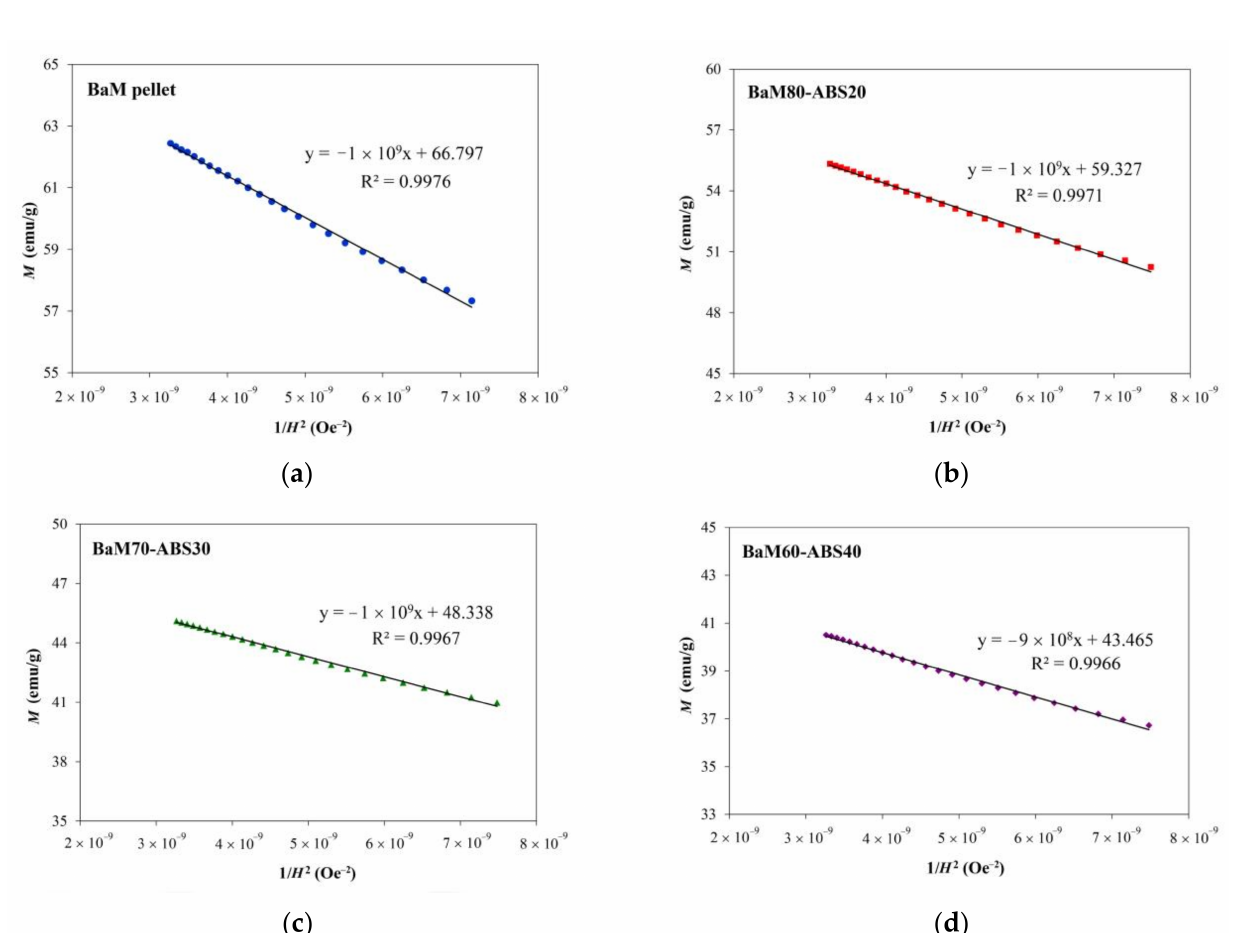
Figure 6. M against 1/ H 2 plots of ( a ) BaM pellet as well as BaM-ABS composites with varying ferrite loading of ( b ) 80%; ( c ) 70%, and ( d )